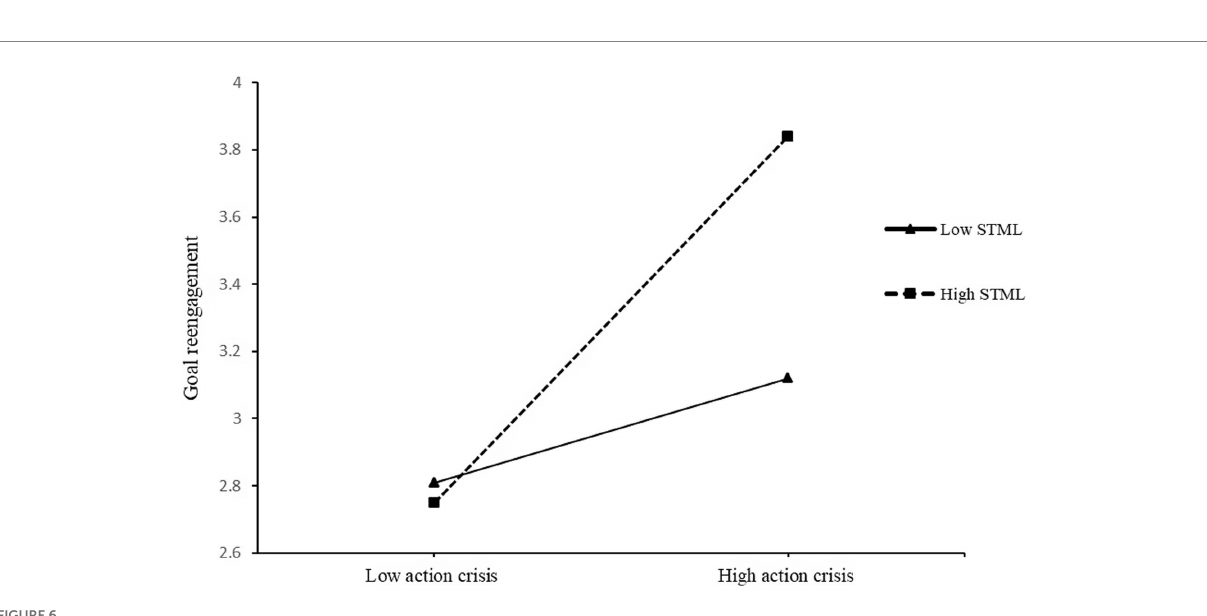
FIGURE 6 Effects of action crisis and self-transcendence meaning of life on goal reengagement in Study 2. STML, self-transcendence meaning of